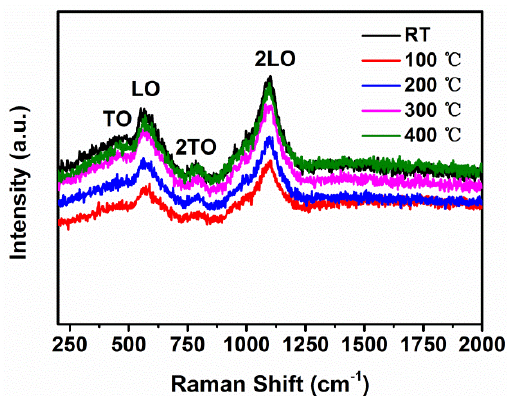
Figure 5. Raman scattering spectra of NiO thin films at different substrate temperatures.